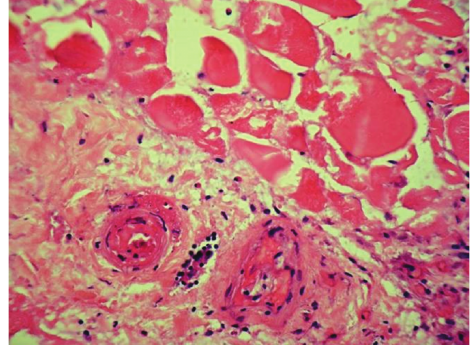
Figure 3: Histologic appearance of muscle tissue demonstrating small blood vessels in area of infarction with inflammation in the walls and thrombotic material in the lumen (Hematoxylin-eosin stain: original magnification